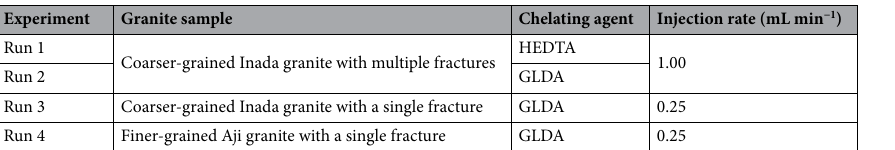
Table 2. Granite samples, chelating agents, and injection rates in each